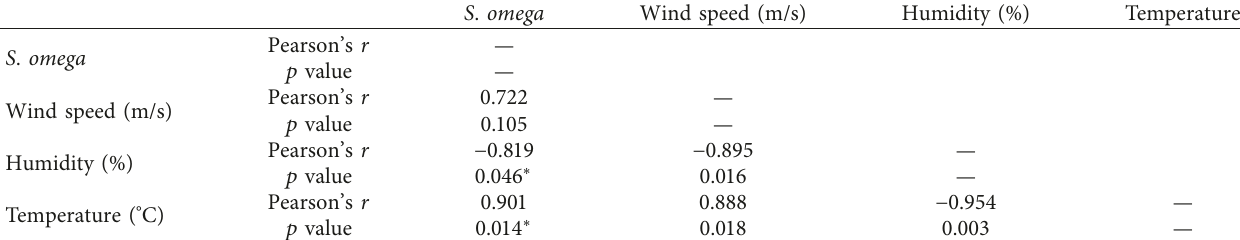
Table 4: Correlation matrix of daily ADT of S . omega with weather variables.